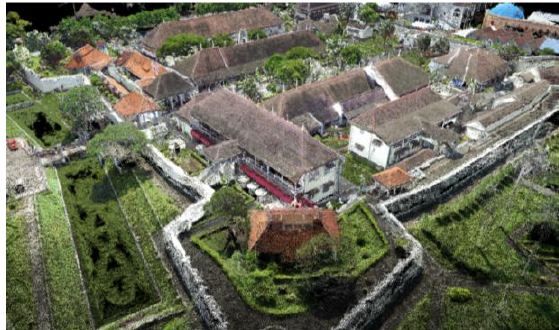
Figure 12. Integration of TLS and UAV pointclouds data by using Iterative Closest Point (ICP)